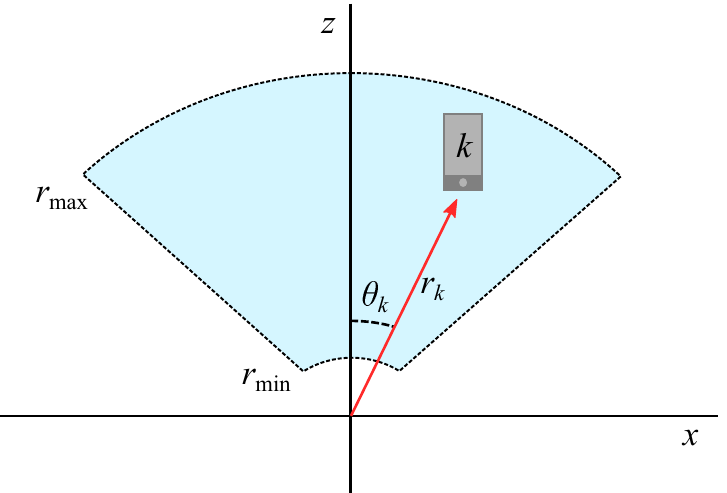
Figure 1. The users are randomly positioned inside the sector ranging from r min = 10 m to r max = 100 m and within − 60 ◦ ≤ θ ≤ 60 ◦ . The k th user is positioned at distance r k and angle θ k . The N -element linear array is aligned with the x -axis and is located at x =